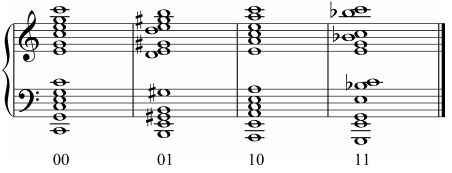
Figure 19. A set of four sources of pitches to build clusters.